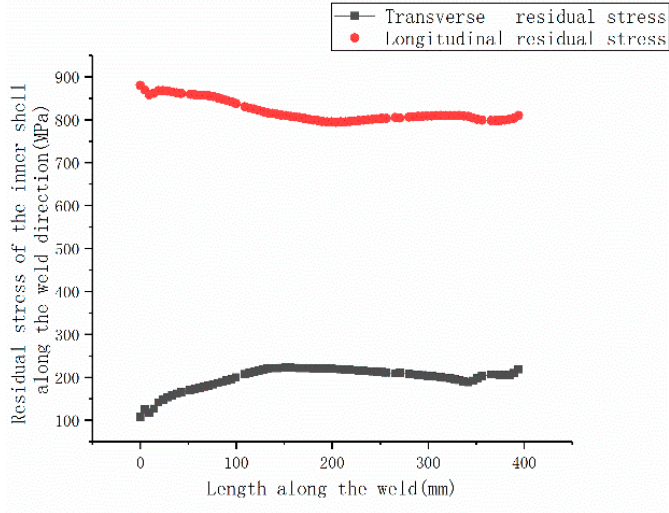
Figure 22. Residual stress along the weld on inner surface of the spherical pressure hull.